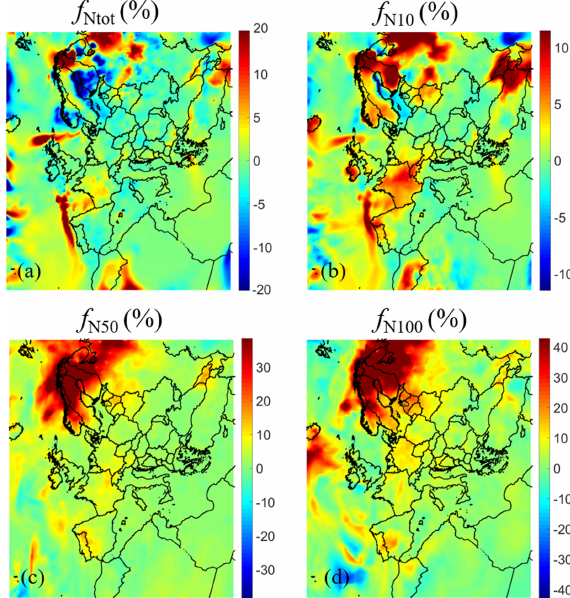
) of number x ), (c) particles above 10 ). Different 100